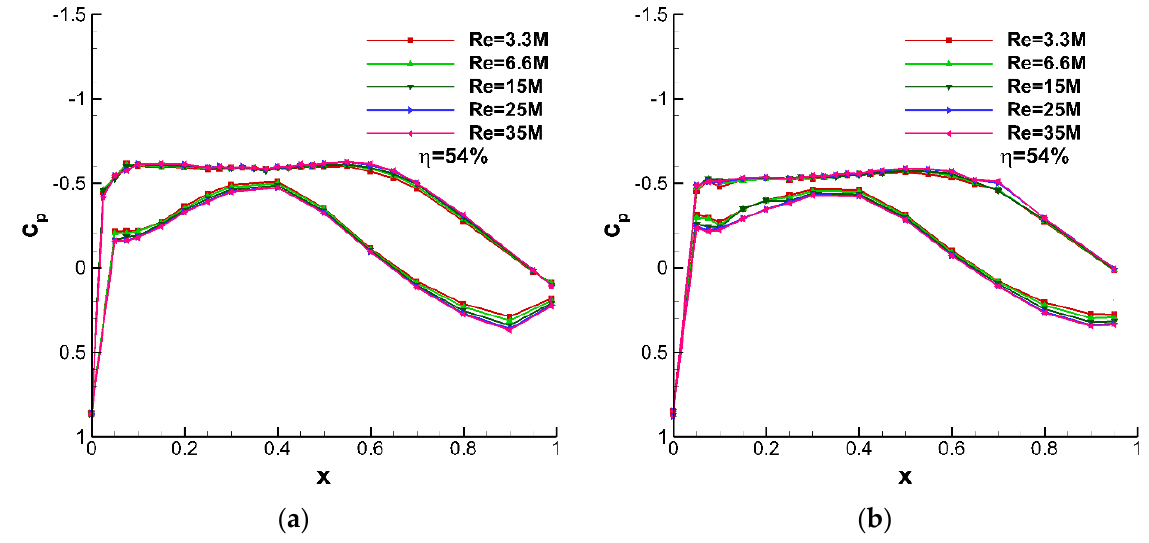
Figure 11. Pressure distributions under different Reynolds numbers (M = 0.76, α = 0°): ( a ) η = 54%; ( b ) η = 72.36%.